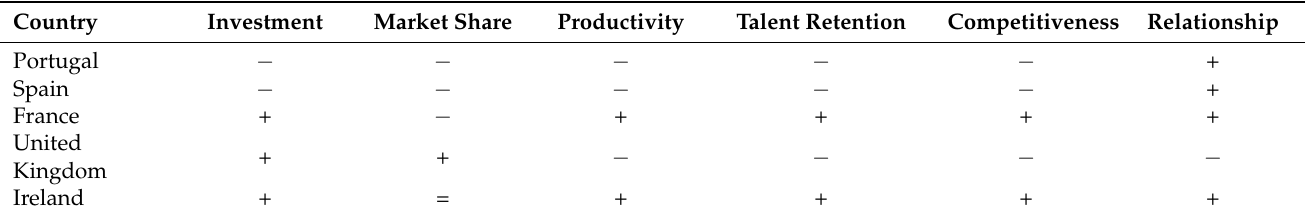
Table 4. Evolution of investment and competitiveness in the Atlantic Area in